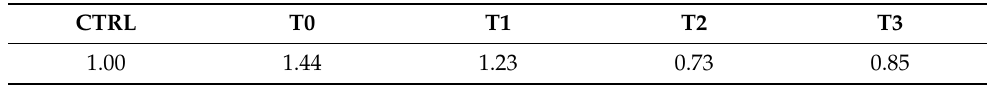
Table 2. IFN scores calculated through the median of the relative quantifications of the six genes of the interferon signature analysis after administration of lower-dose sulforaphane (SFN) supplement in the first healthy volunteer (HV1).